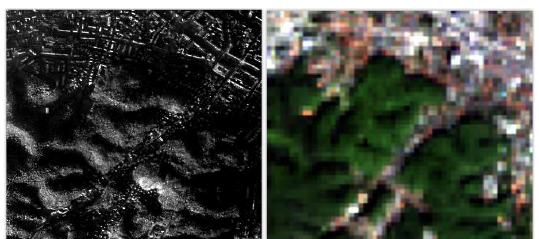
Figure 2. Forest area. Left image: panchromatic imagery from Eros. Right image: multispectral imagery from Landsat-8 in the band combination 4 (red), 3 (green), 2 (blue)